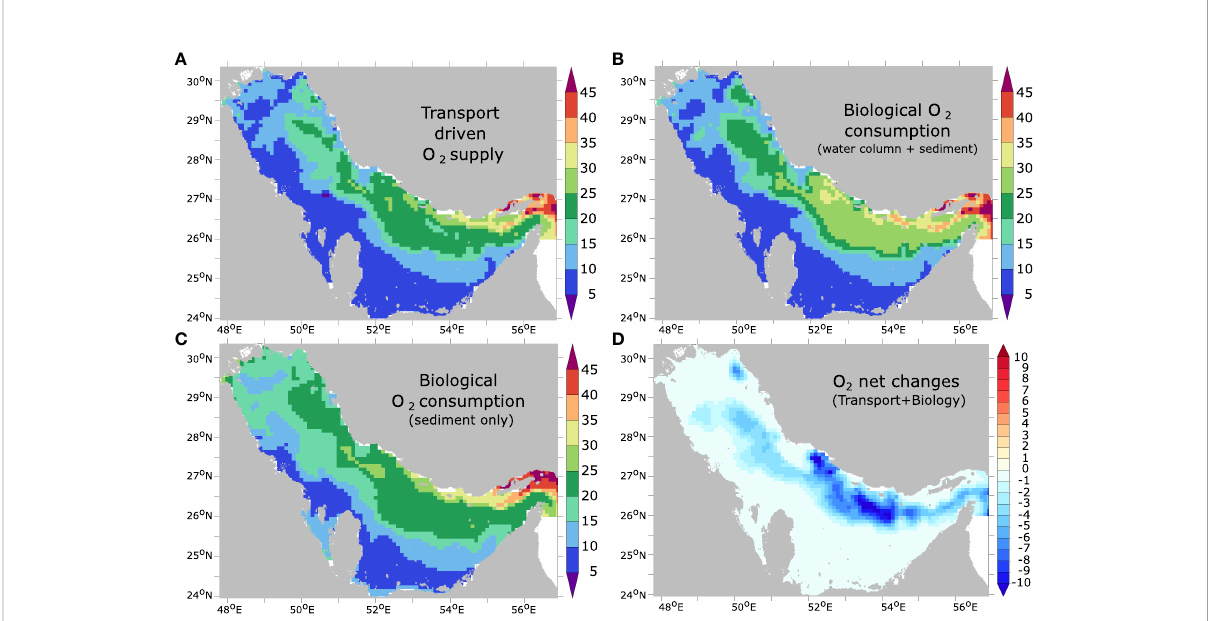
FIGURE 8 Near-bottom O 2 budget between 1982 and 2010. Cumulative O 2 supply due to transport (in Gmol) (A) and cumulative O 2 sink due to biological consumption in the water column and the sediment (B) and in the sediment-only (C) (in Gmol N) integrated over the study period in the deepest (bottom) layer. (D) cumulative net O 2 sources minus sinks (transport-biology) integrated over the study period in the bottom layer (in Gmol